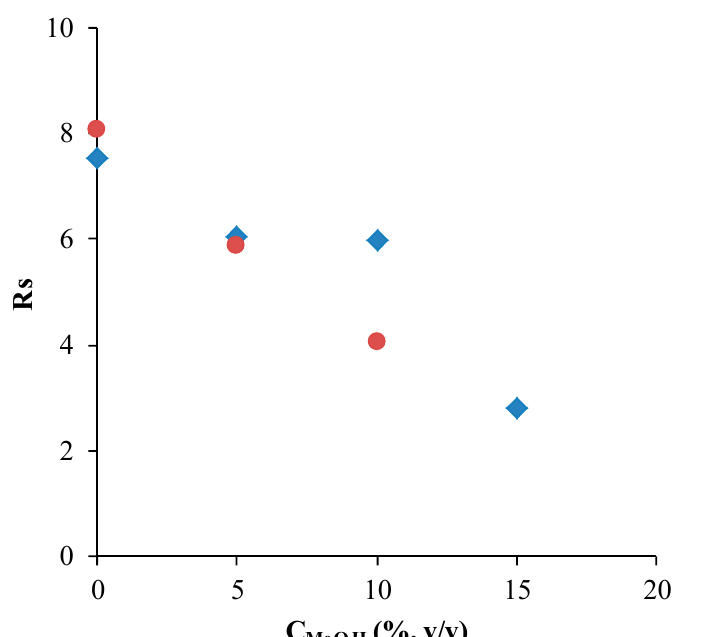
Figure 1. Effect of the methanol concentration in the background electrolyte (BGE) on the resolution at two concentration of HS ‐γ‐ CD: ( ⚫ ) 0.1 and ( ◆ ) 0.05 (%, m/v). Other separation conditions: BGE, 50 mM phosphate buffer at pH 7.0; 20 kV; 25 °C.